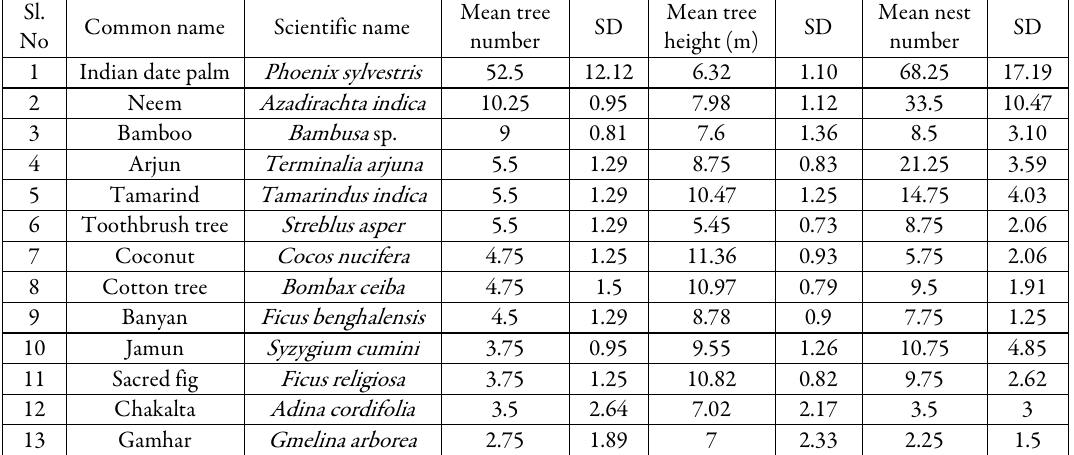
Table 3. Summary of number, height of nesting trees of different species and nest numbers (mean ± SD) per tree recorded during four years (2017 to 2020) in the study area Sl.